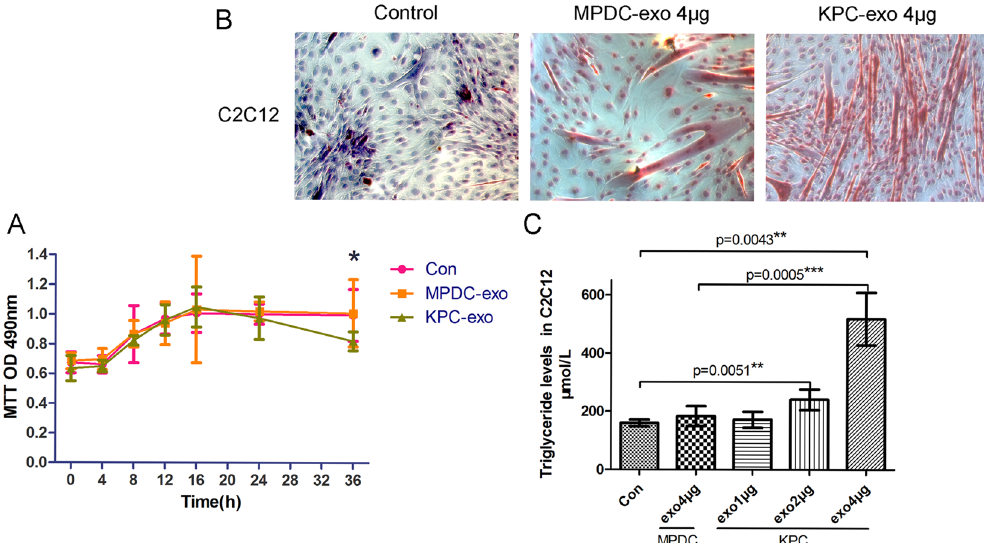
Figure 2. The effect of KPC-exosomes on the survival and triglyceride level of C2C12 cells. ( A ) Cell viability at different time points (0 h, 4 h, 8 h, 12 h, 16 h, 24 h and 36 h). * P < 0.05. Cells were cultured in 96-well plates treated with 5 μ g/ml exosomes in each well. ( B ) Oil Red O Staining was used to observe lipidosis in C2C12 myotubes. Cells were cultured in 25-cm 2 culture-flasks with 5 ml DMEM. Images were captured at 20 × magnification. ( C ) The intracellular triglycerides of the C2C12 myotubes were quantified and analysed. Cells were cultured in 25-cm 2 culture-flasks with 5 ml DMEM. * P < 0.05, ** P < 0.01, *** P < 0.001.